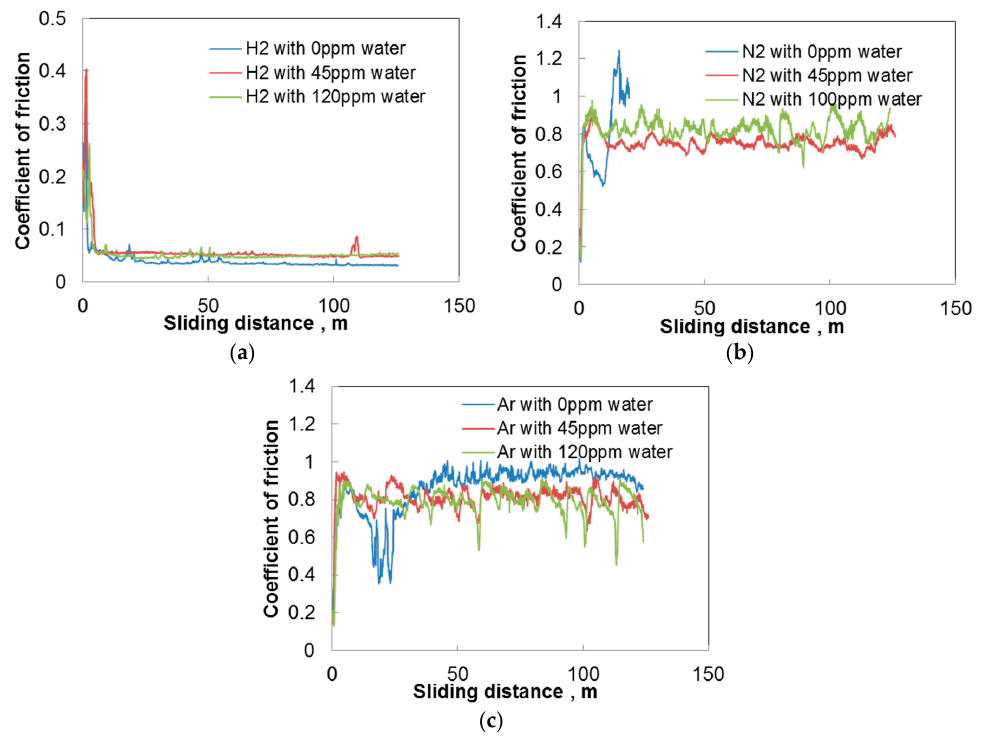
Figure 8. Changes in the coefficient of friction with sliding distance; ta-C DLC disk and aluminum pin; ( a ) in hydrogen; ( b ) in nitrogen; and ( c ) in argon.